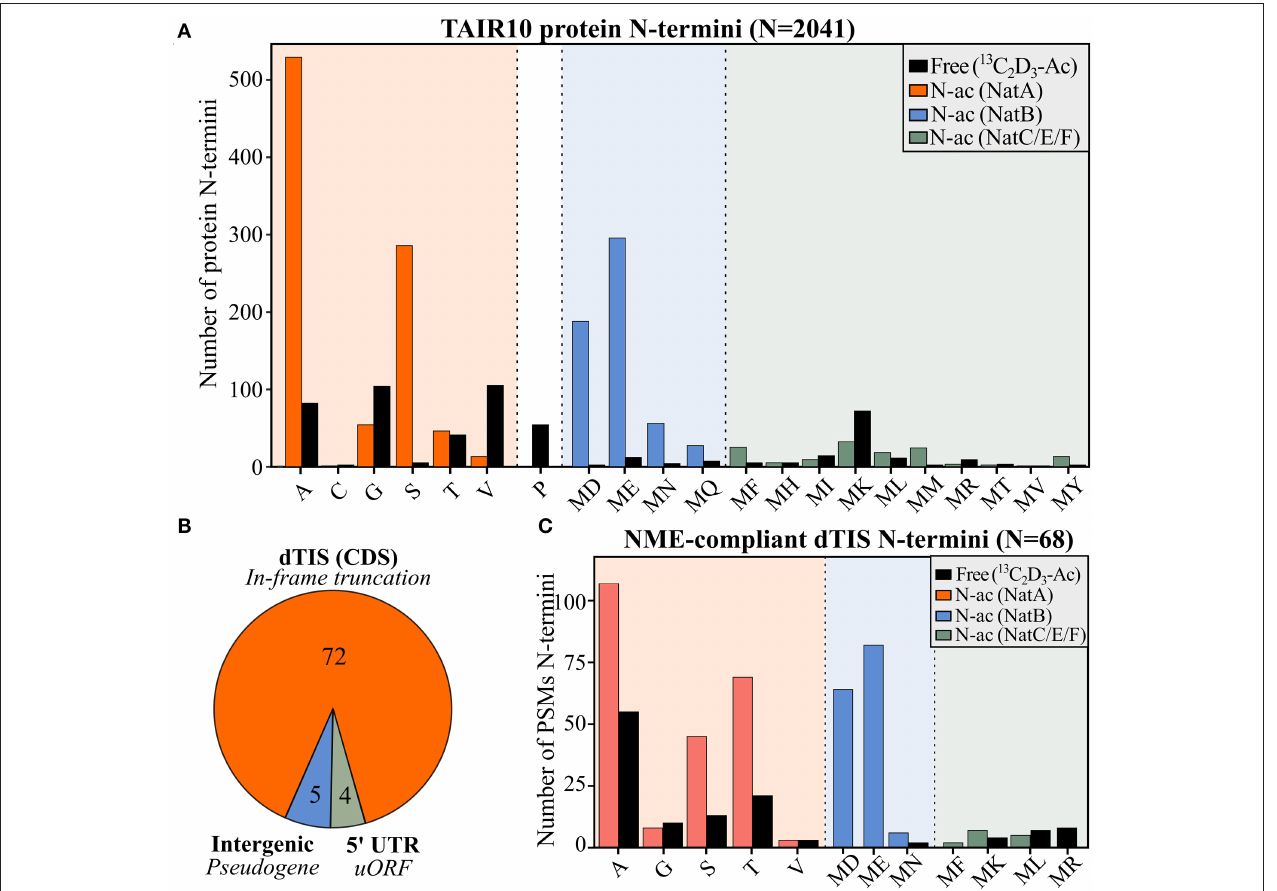
FIGURE 2 | N-terminal peptide evidence for annotated and alternative TIS. (A) Number of identified Nt acetylation (NTA) or Nt-free ( 13 C 2 D 3 -Ac) peptides matching TAIR10-annotated protein starts (position 1 or 2) in function of the identity of the ultimate N-terminal residue. (B) Distribution of aTIS ( N = 81) matching the by N-terminal proteomics-identified alternative N-termini with respect to their location to TAIR10 gene models, being either intergenic, located in the 5 ′ UTR or downstream (dTIS) and in-frame in the CDS. (C) Peptide-to-spectrum matches (PSMs) are indicated for the 68 NME-compliant N-termini identified matching in-frame called dTIS of TAIR10 CDSs ( Supplementary Dataset S2 ). In vivo Nt-free N-termini, labeled in vitro by 13 C 2 D 3 -Ac, are colored in black, while in vivo NTA N-termini matching NatA, NatB, or NatC/E/F specificities are indicated in orange, blue, and green, respectively.